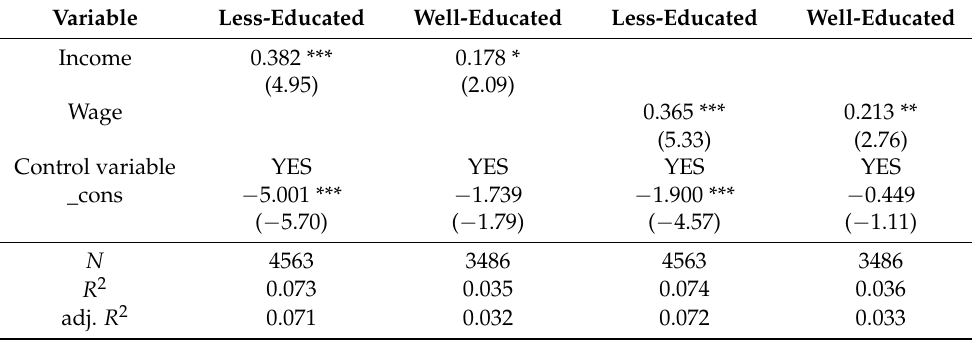
Table 6. Heterogeneous effects of different education levels on income. Variable